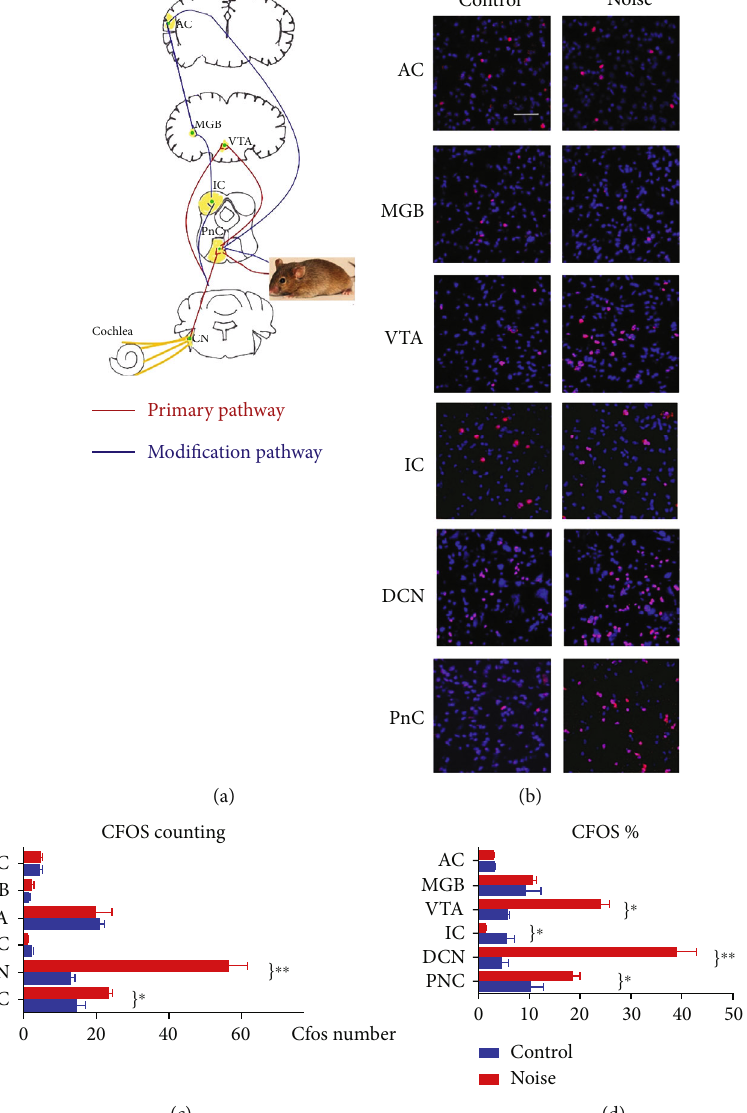
Figure 4: C-Fos expression in di ff erent sites of the auditory pathway. (a) Schematic of the primary ascending pathway and the descending modulatory pathway of acoustic startle response (ASR). (b) Immuno fl uorescence results of the caudal pontine reticular nucleus (PnC), the inferior colliculus (IC), dorsal cochlear nucleus (DCN), medial geniculate body (MGB), ventral tegmental area (VTA), and the auditory cortex (AC). (c) The number of c-Fos-positive cells in the noise-exposed group was signi fi cantly higher than the control group in the PnC and DCN. (d) The proportion of c-Fos staining in di ff erent parts of the auditory pathway. The c-Fos in the DCN, PnC and VTA of the noise group was signi fi cantly higher than the control group ( ∗ p < 0 : 05 positive cells after noise exposure, 5 : 42 ± 1 : 72 % for the con- trol group and 1 : 43 ± 0 : 29 % for the noise group ( p < 0 : 05 ). There was no signi fi cant di ff erence in MGB and AC between the two groups ( p > 0 : 05 ).